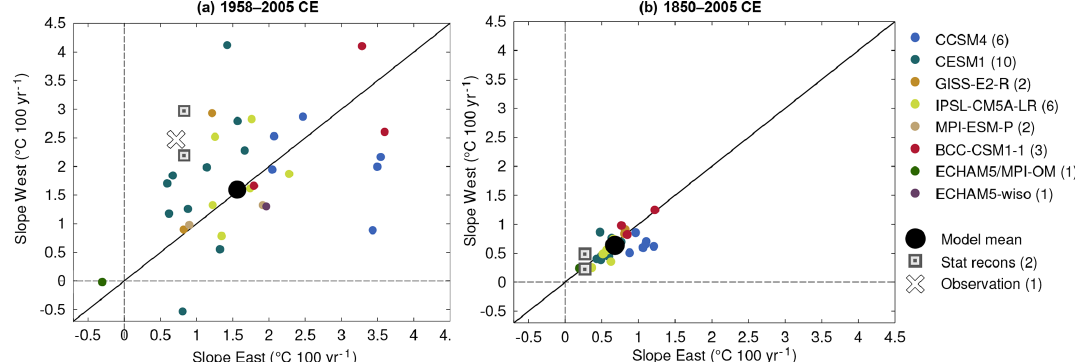
Figure 2. Comparison between the reconstructed, simulated and observed surface temperature slopes (in ◦ C/100 year) in West Antarctica ( y axis) and in East Antarctica ( x axis), over the (a) 1958–2005CE and (b) 1850–2005CE